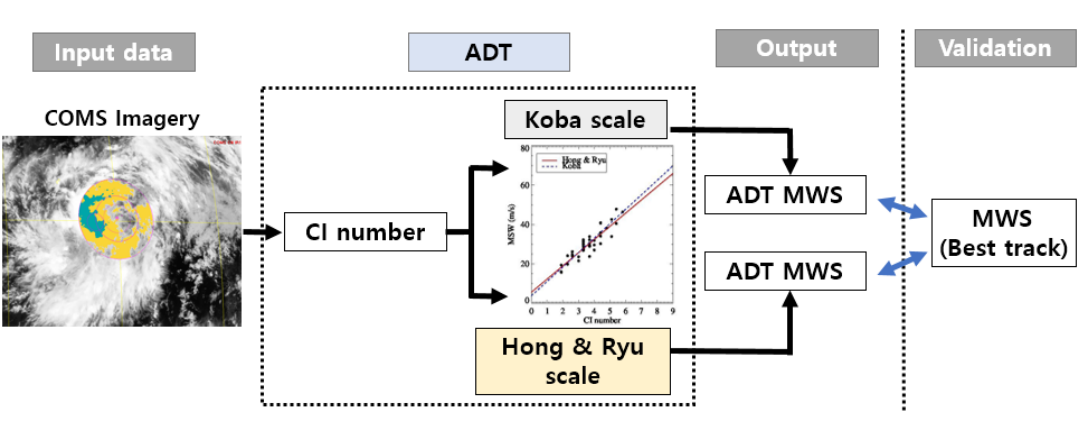
Figure 5. Validation procedure of the Hong and Ryu scale CI to MWS conversion scale for northwestern Pacific TCs.